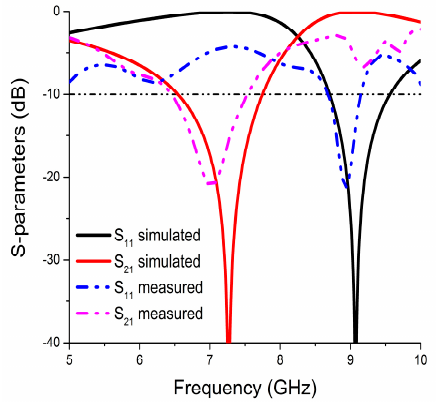
Figure 4. Simulated and measured S-parameters of the printed resonator.